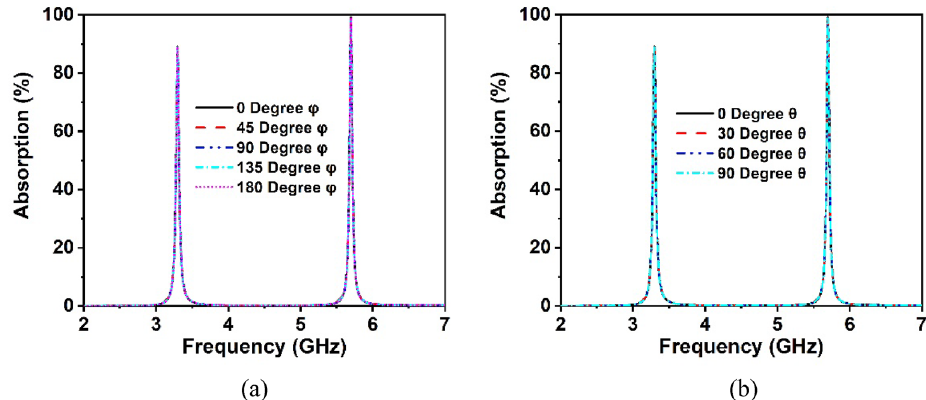
Figure 18. Absorption performance of the proposed MM structure (array) for ( a ) normal angle of incidence and ( b ) oblique incidence.